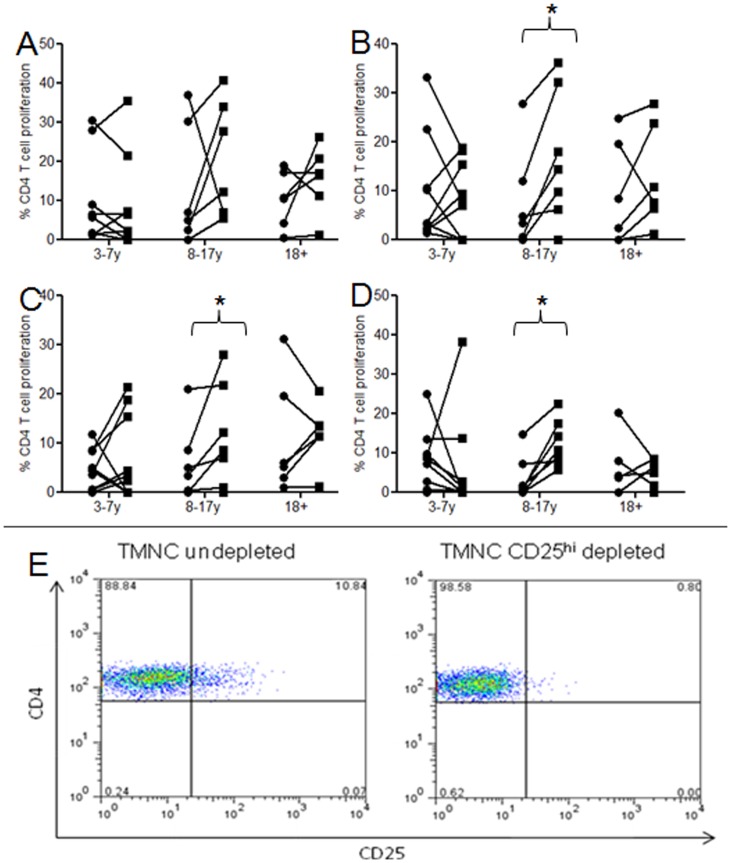
Inhibition of pneumococcal, influenza and MTB responses by regulatory T cells in young children and onwards.Mucosal CD4 T cell responses to pneumoCCS (a) and PlyCCS (b) influenza (c) and MTB PPD (d) by CD25hi regulatory T cells in subjects above 3 years old as indicated by increased cell proliferation following depletion of CD25hi cells from tonsillar MNC population. Subjects (n = 22) were grouped into those aged 3–7 yrs, 8 to 17 yrs and >18 yrs. Individual subject’s proliferative response pre (circle) and post CD25hi cell depletion (square) are shown with a connecting lines. Data was analyzed using Wilcoxon signed rank test, * = p<0.05. Representative flow cytometric plot of CD25 undepleted and depleted tonsillar mononuclear cells (TMNC) (e).